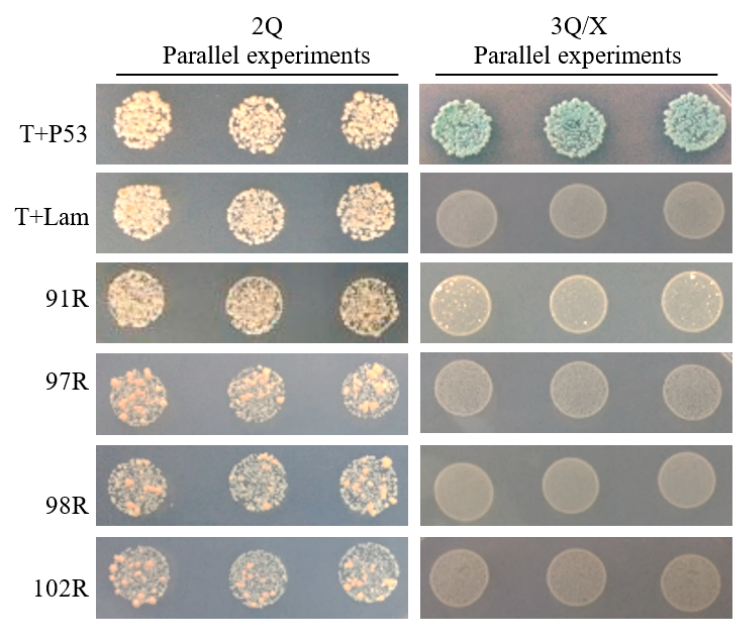
Figure 1. The formed yeast colonies during testing interactions between RGV-63R and four proteins by Y2H. Three parallel experiments were performed. 2Q: SD/-Trp/-Leu. 3Q/X: SD/-Trp/-Leu/-His/X- α -Gal. 91R, 97R, 98R, and 102R: RGV proteins, which are encoded by iridovirus core genes, respectively. T+P53: the positive control; T+Lam: the negative control.